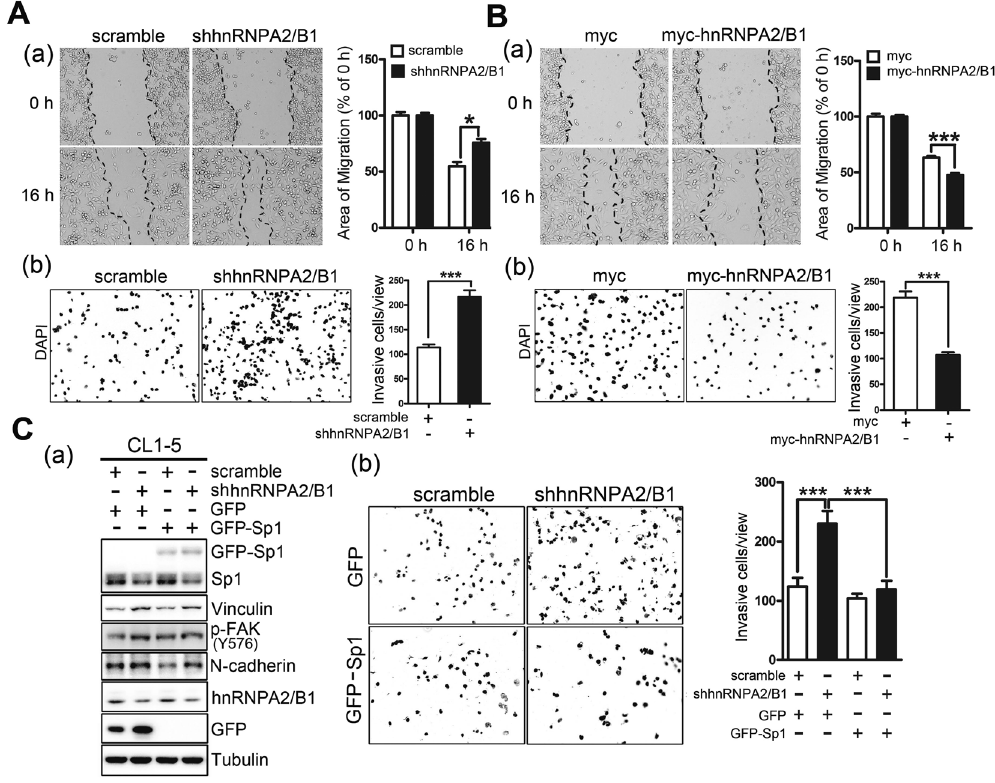
Figure 7. The effect of hnRNPA2/B1 on Sp1-mediated lung cancer migration. ( A , B ) Cell mobility was assayed with a wound healing assay (a) and transwell assay (b) in hnRNPA2/B1 knockdown ( A ) or myc-hnRNPA2/ B1-overexpressed cells ( B ). After three independent experiments, the migratory area and cell number were quantified, and statistical analysis was done with a t-test, * p < 0.05; *** p < 0.005. ( C ) The protein levels and cell mobility were assayed on the hnRNPA2/B1-silenced cells with or without GFP-Sp1 expression by Western blotting with antibodies against the indicated proteins (a) and by transwell assay (b). After three independent experiments were finished, the cell number on the chamber was quantified and the statistically analysis was performed with t-test, *** p <